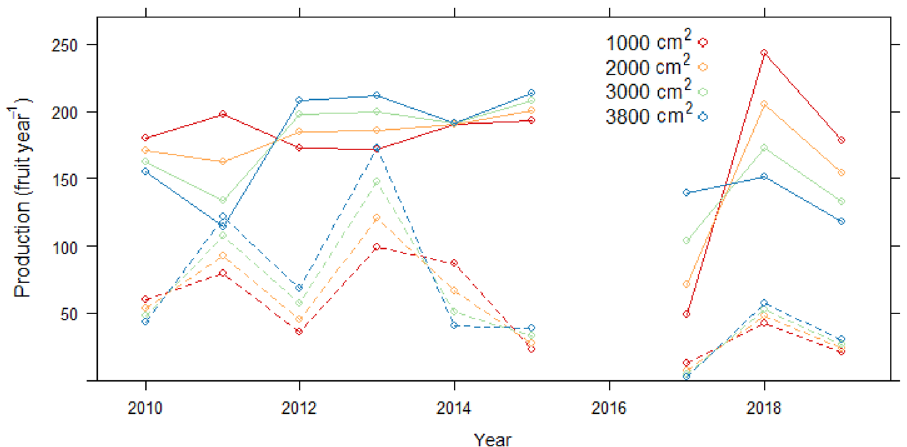
Figure 6. Model 3b marginal mean values of annual fruit production of large trees (DBH ≥ 100 cm) by four values of sapwood area (cm 2 ). Solid lines = Cachoeira, dashed lines =